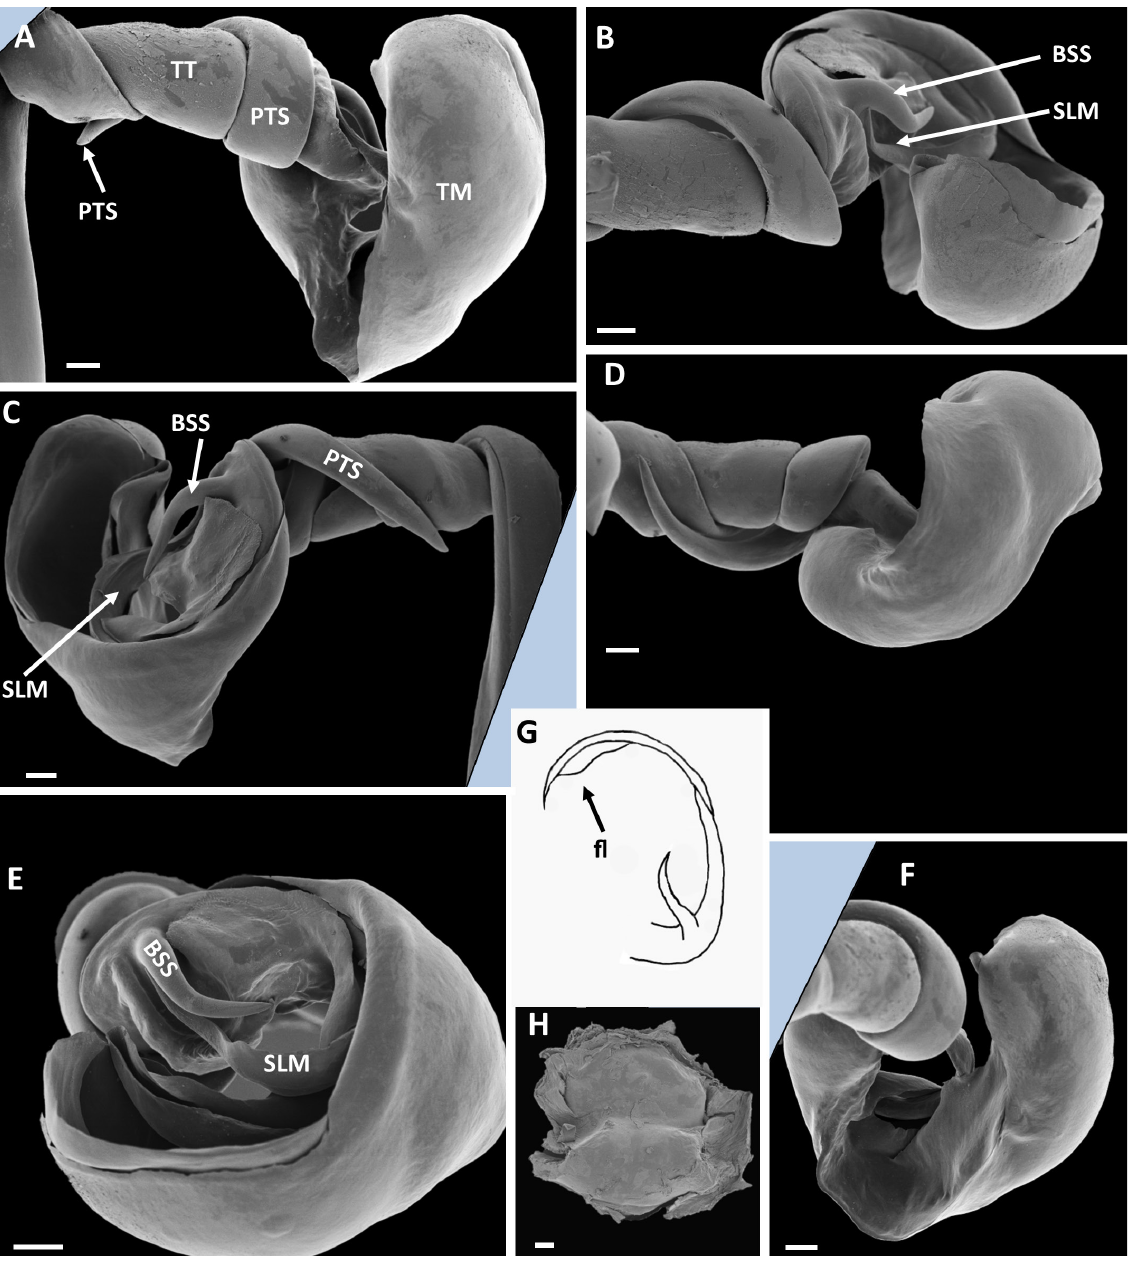
Fig. 18. Calyptomastix vuasu sp. nov., holotype, ♂ (NHMD 621717). A–F . Left gonopod telopodite. A. Anterior view. B. Ventral view. C. Posterior view. D. Dorsal view. F. Mesal view. G . Right gonopod solenomere. H . Sternum 9. Abbreviations: BSS = basal solenomeral spine; fl = flange; PTS = post-torsal spine; SLM = solenomere; TM = telomere; TT = torsotope. Light blue areas obscured covered by mounting tape. Scale bars: A–F, H = 0.1 mm; G not to